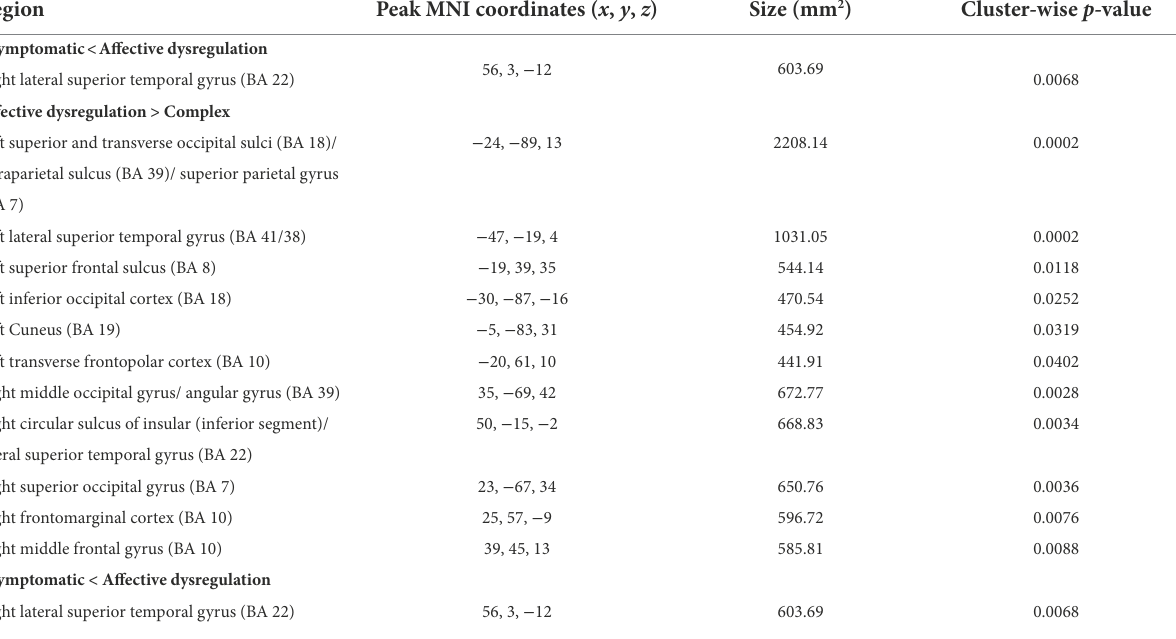
TABLE 6 Brain regions showing differences in cortical thickness between the subgroups of pariticipants classified based on profiles of MBI domain symptoms. Region Peak MNI coordinates ( x , y , z ) Size (mm 2